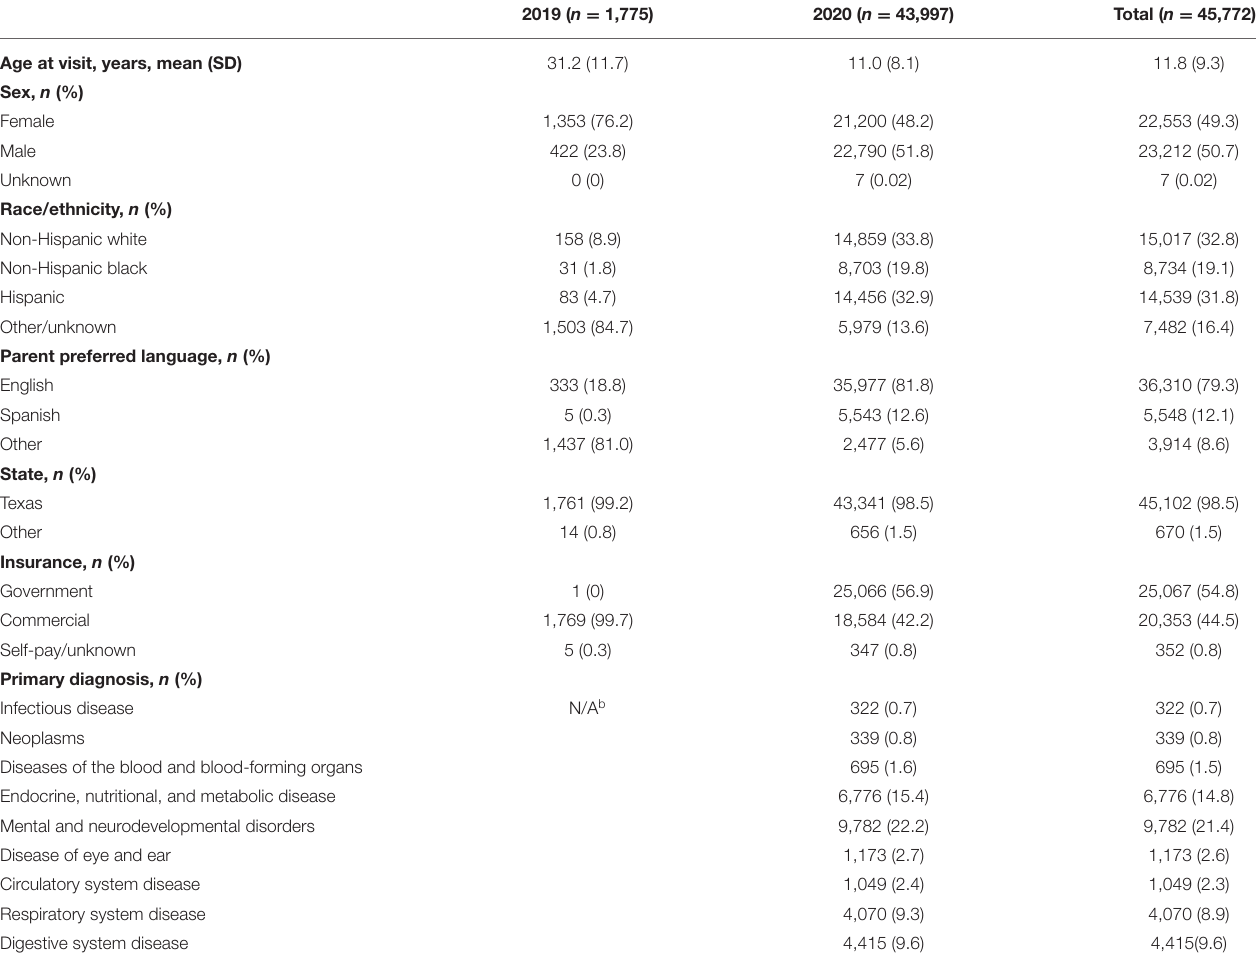
TABLE 2 | Characteristics of patients based on telehealth visits, Jan–Oct 2019 and